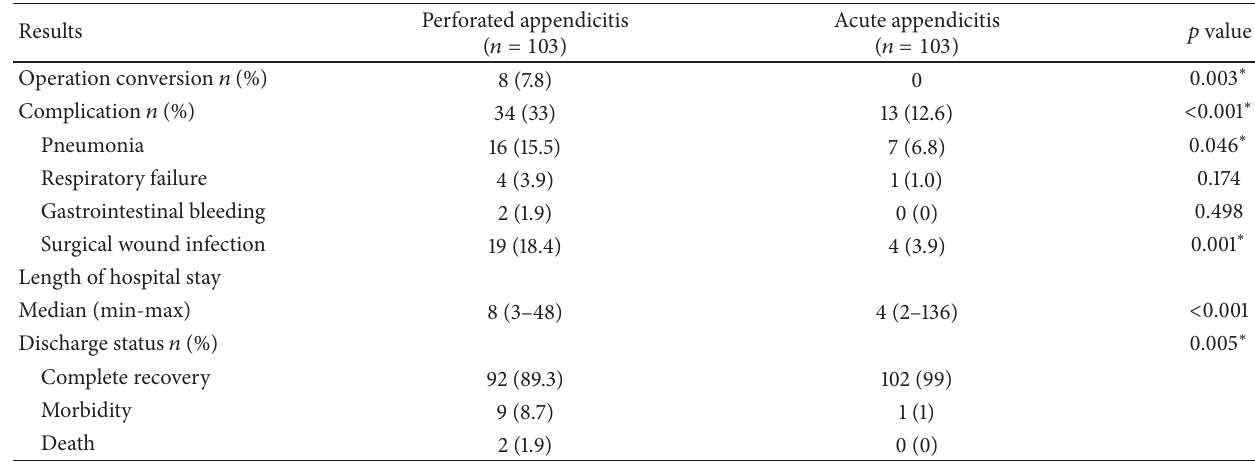
Table 5: Outcomes, complications, and length of hospital stay.